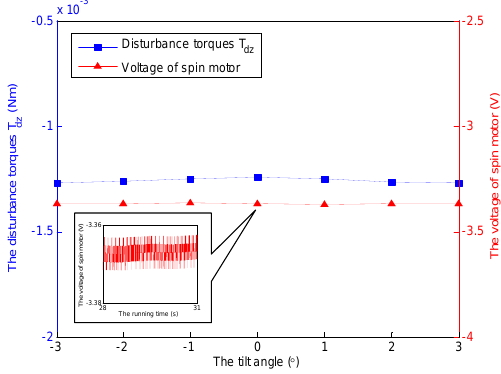
Figure 14. Comparisons of T dx and T dy with varying tilt angles φ x under φ y = 0 ◦ and 3500 rpm. ( a ) Comparison of T dx ; ( b ) Comparison of T dy .